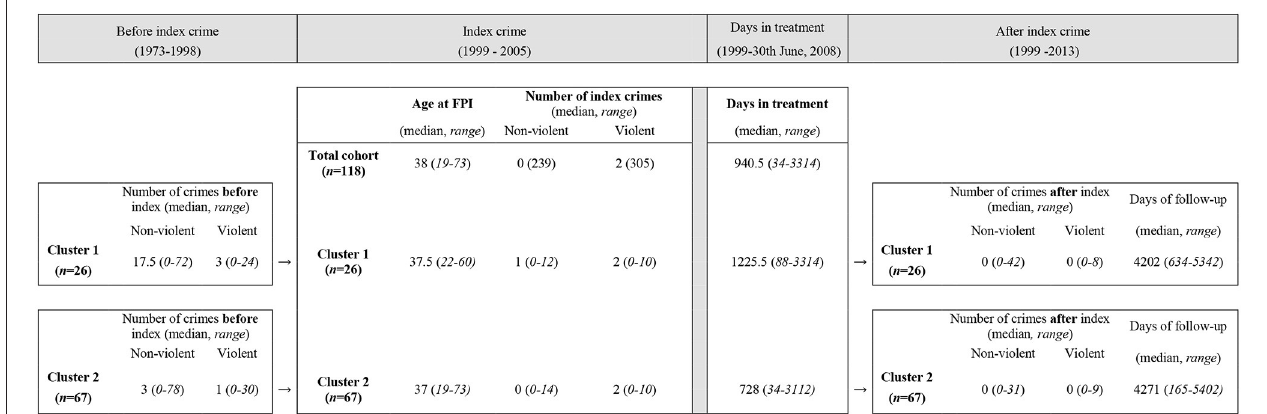
FIGURE 2 | Lifetime criminality before, at, and after index crime.